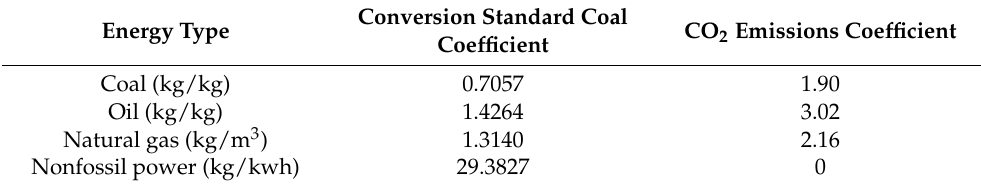
Table 3. The carbon emissions coefficient of various energy